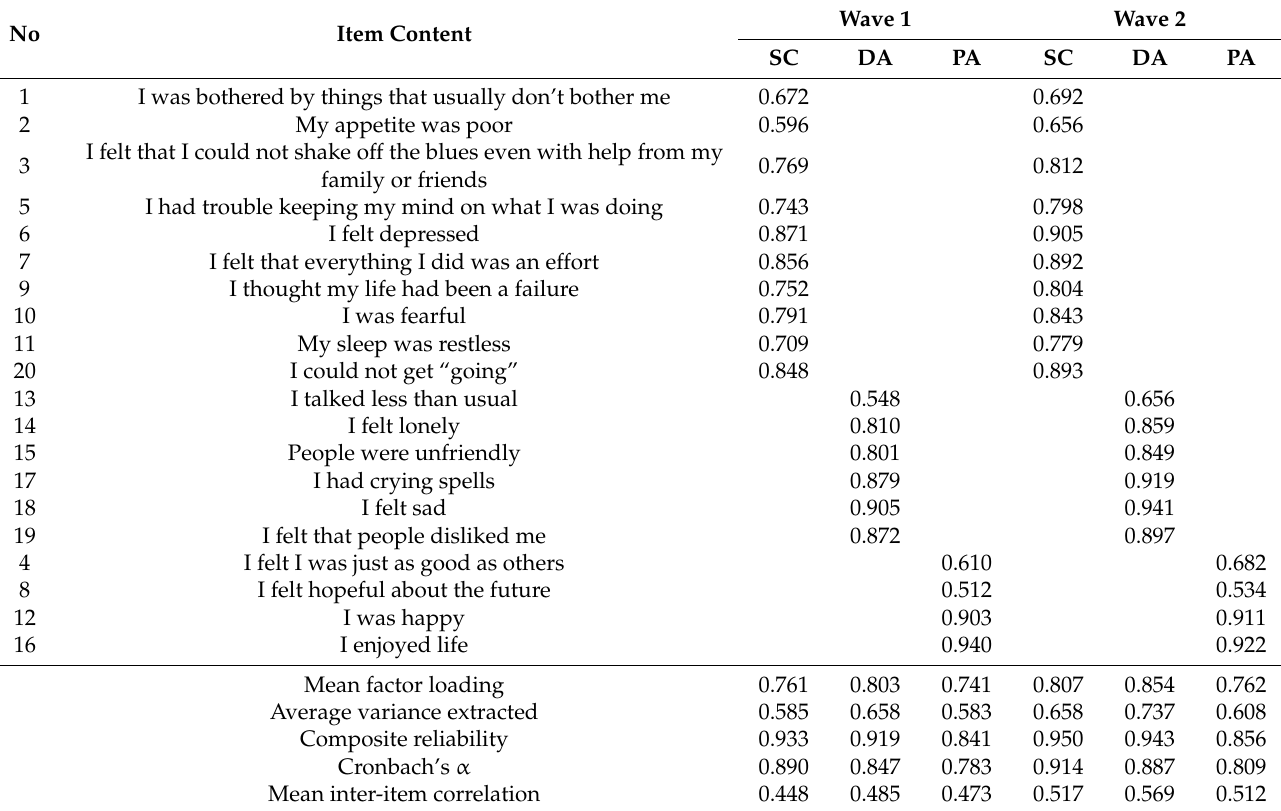
Table 5. Standardized factor loadings and psychometric properties for the longitudinal invariance model of